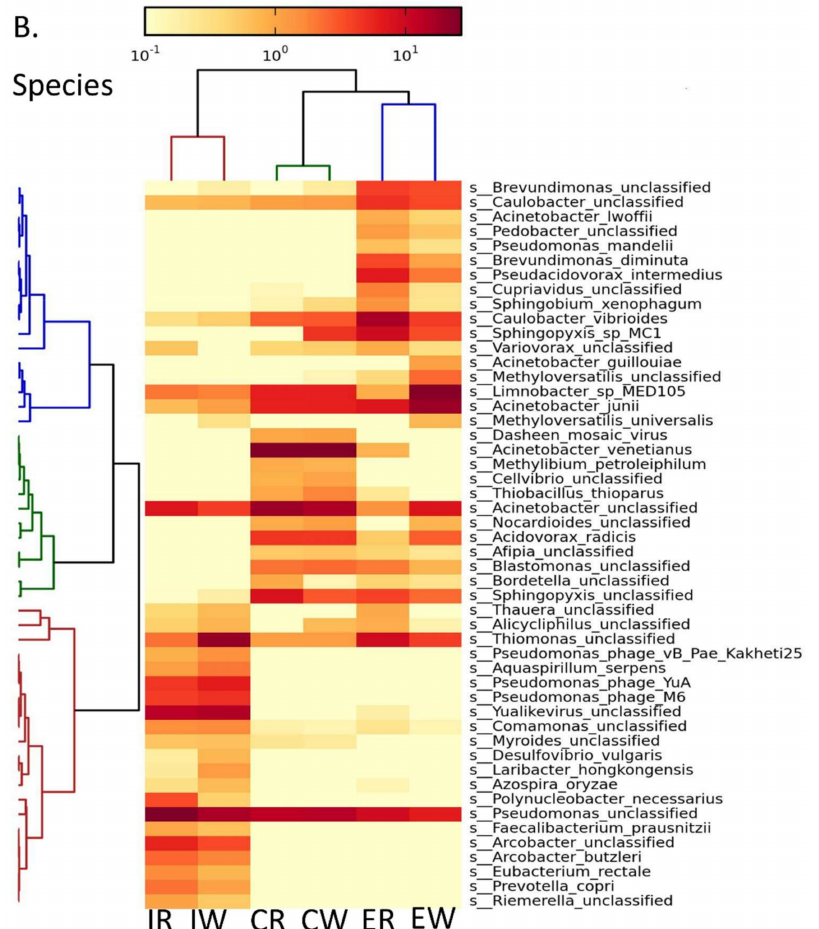
Figure 1. Heat map representing relative abundances of genera ( A ) and species ( B ), detected in the wastewater samples collected in July, October and November 2015. Colored scale bar represents the relative abundances for each heat map. IR: Influent-retentate, IW: Influent-wash, ER: Effluent-retentate, EW: Effluent-wash, CR: Chlorinated Effluent-retentate, CW: Chlorinated